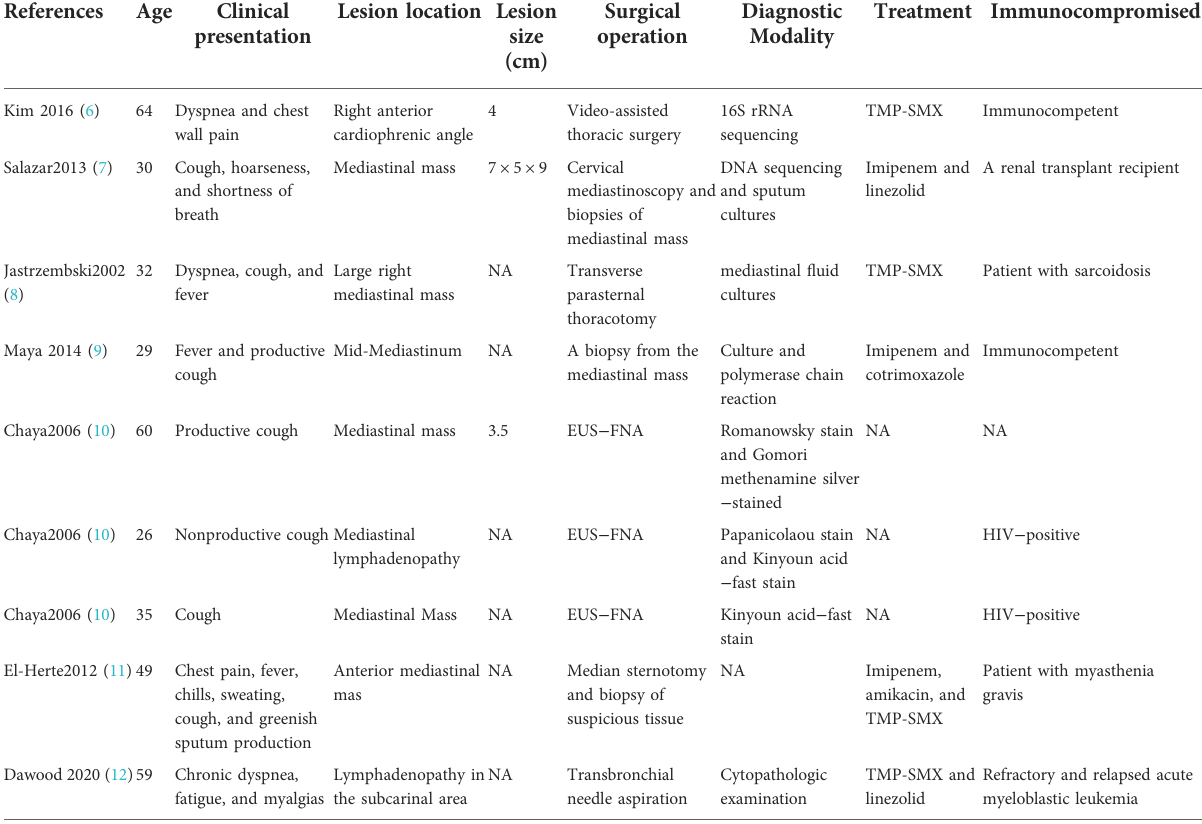
TABLE 1 Case summary of Nocardia infection presenting as a mediastinal